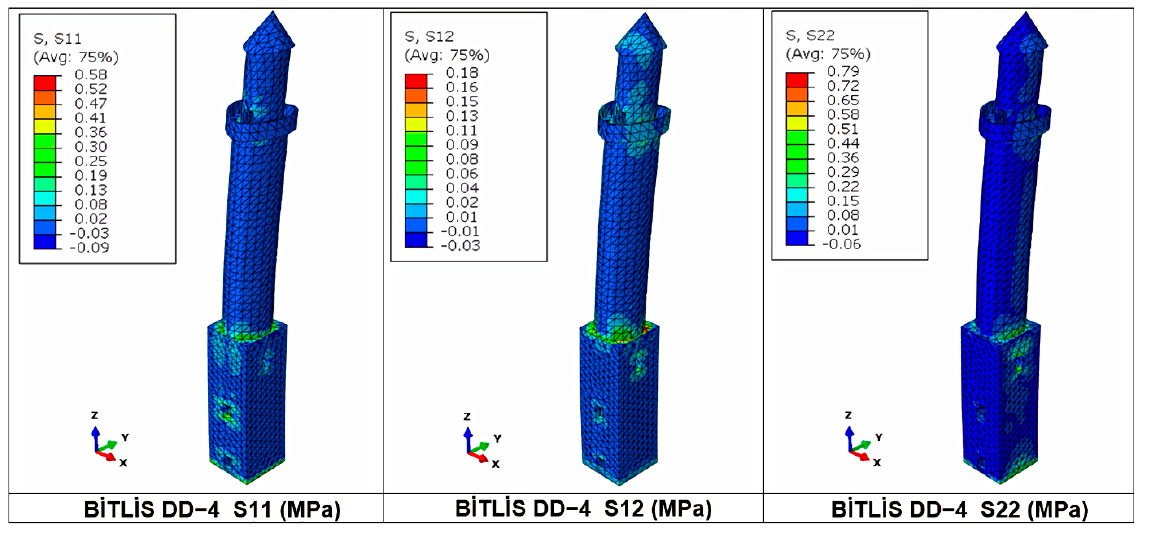
Figure 25. Stresses for DD − 4 ground motion level.